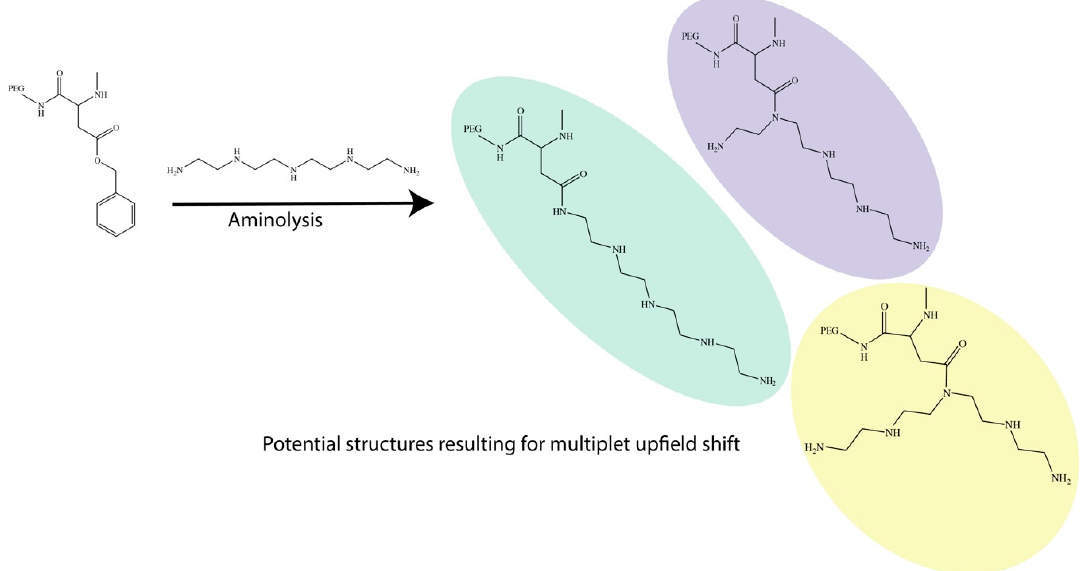
Figure 2. Due to the nature of the nucleophilic substitution of the benzylic alcohol, we postulated the range of different reaction sites on the polyamine as exemplified by the reaction of TEP, resulting in possible differences in extension of arms.